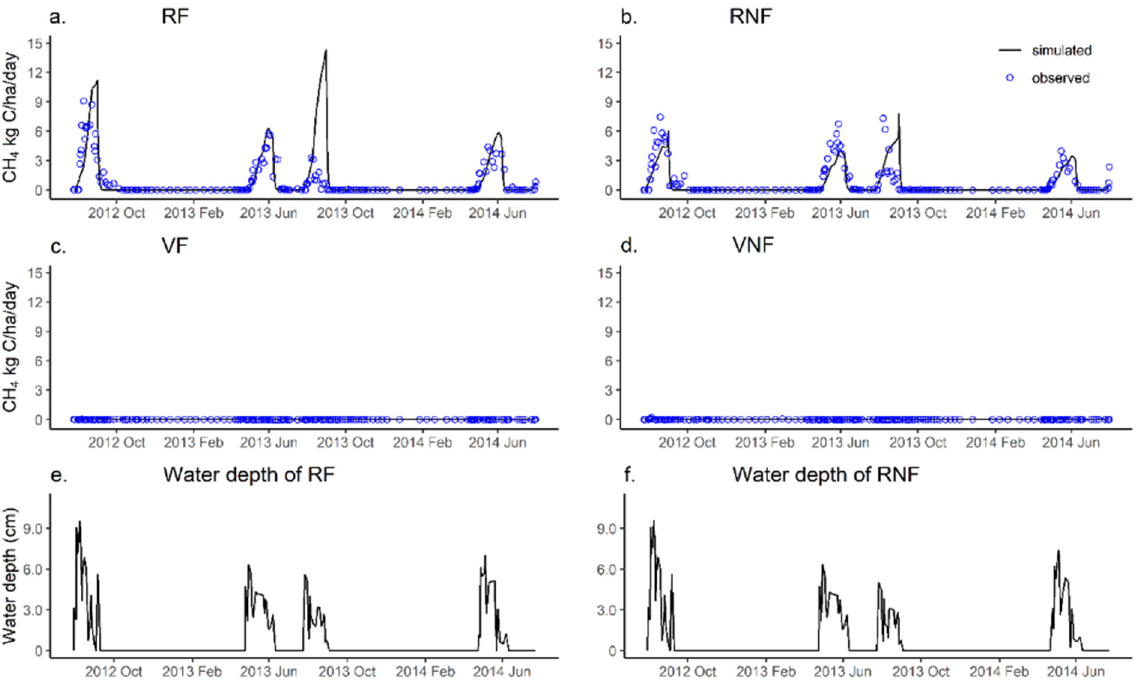
Figure 2. Observed and simulated ( a – d ) daily CH 4 emission and ( e , f ) water depth from 2012 to 2014 under the different cropping systems and fertilization levels. RF: rice with fertilization; RNF: rice without fertilization; VF: vegetable with fertilization and VNF: vegetable without fertilization. Table 3. Statistics for the observed and simulated daily CO 2 , CH 4 and N 2 O emissions under the different cropping systems and fertilization levels *. RF: rice with fertilization; RNF: rice without fertilization; VF: vegetable with fertilization and VNF: vegetable without fertilization; RMSE is root mean square error; R 2 is coefficient of determination; d is d-index [40].